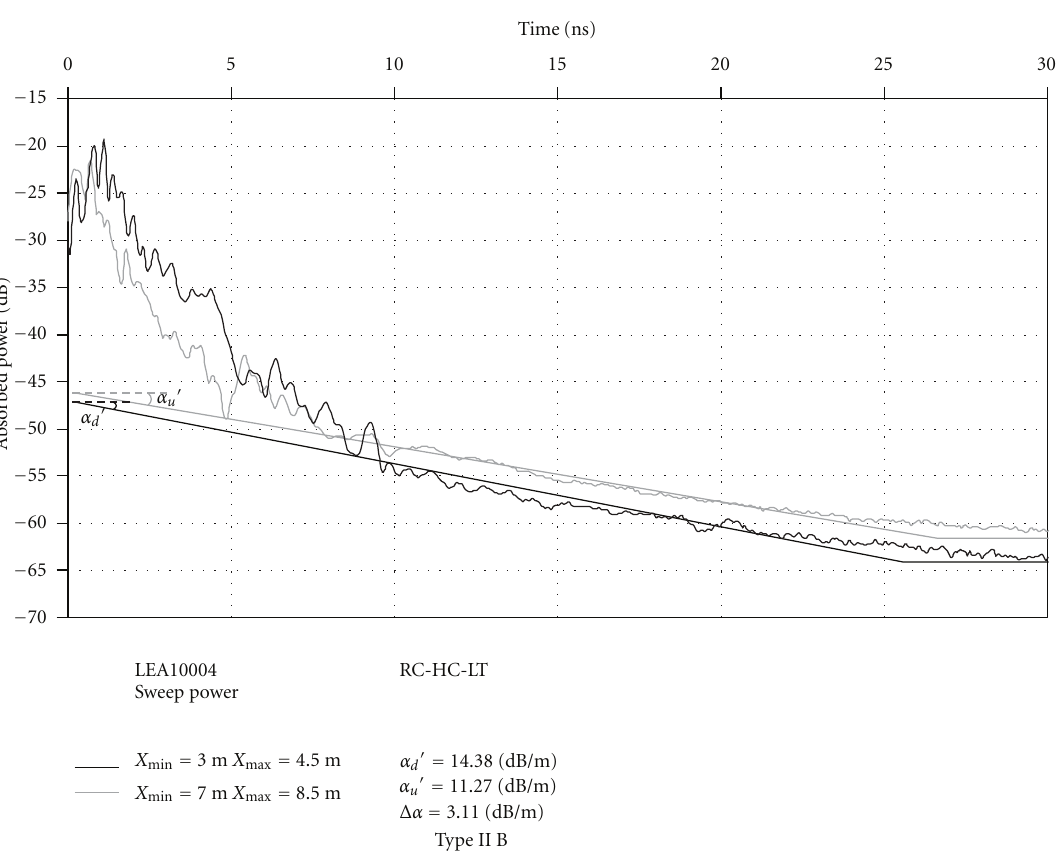
Figure 10: Power diagram (case Δ α > 0) of the 1600 MHz section reported in Figure